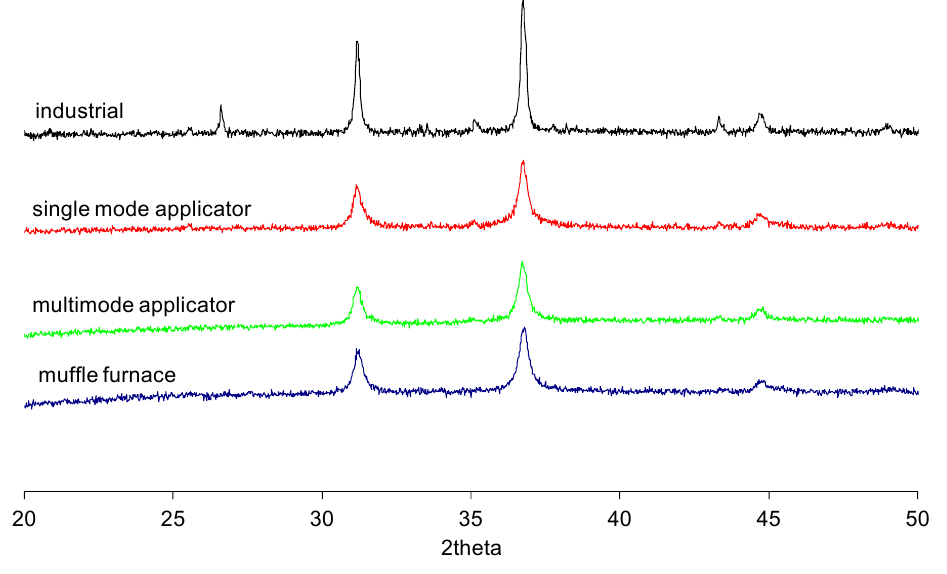
Figure 6. X-Ray diffraction patterns of powders calcined at 1200 °C by different techniques, Figure 6. X-ray diffraction patterns of powders calcined at 1200 ◦ C by different techniques, compared compared to the industrial standard. to the industrial